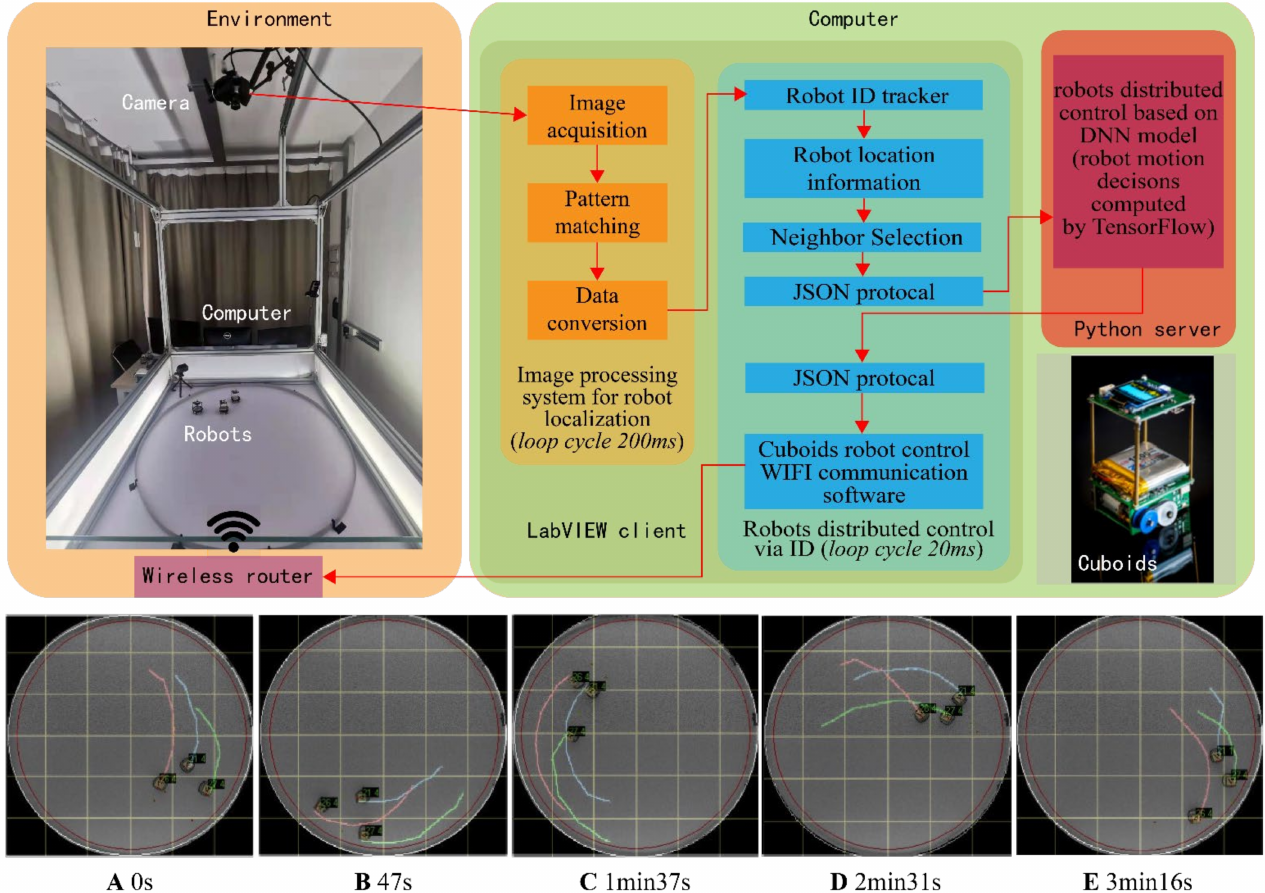
Figure 10. The Cuboid robots’ platform and the top view sequence of the collective motion experiment.